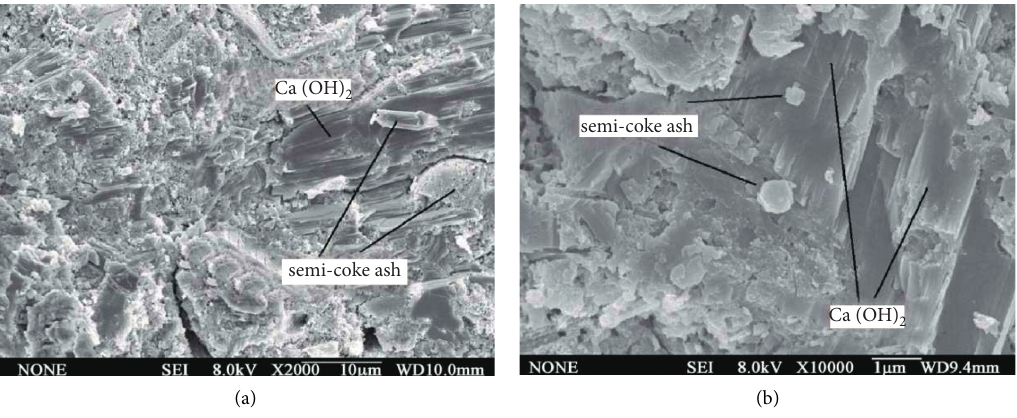
Figure 17: Microstructure of SAC1. (a) X2000; (b)